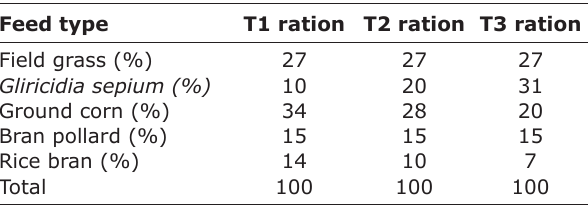
Table-2: Comparison of feed ingredients composition and ration of complete feed for Bali cattle fattening. Feed type